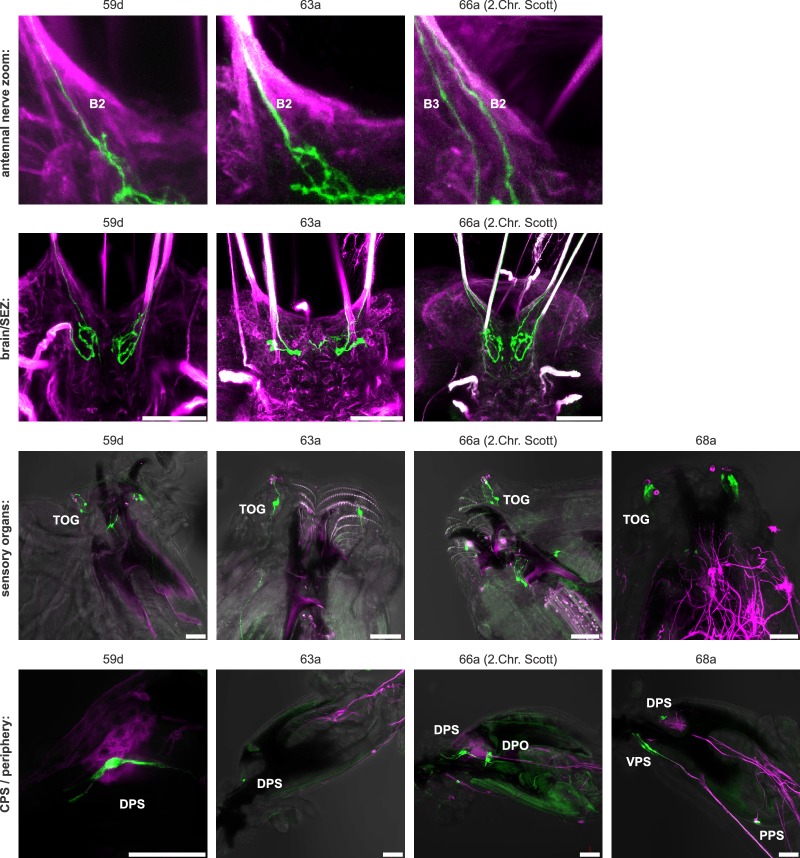
Gustatory receptor expression.Top row scale and all scale bars = 50 µm.